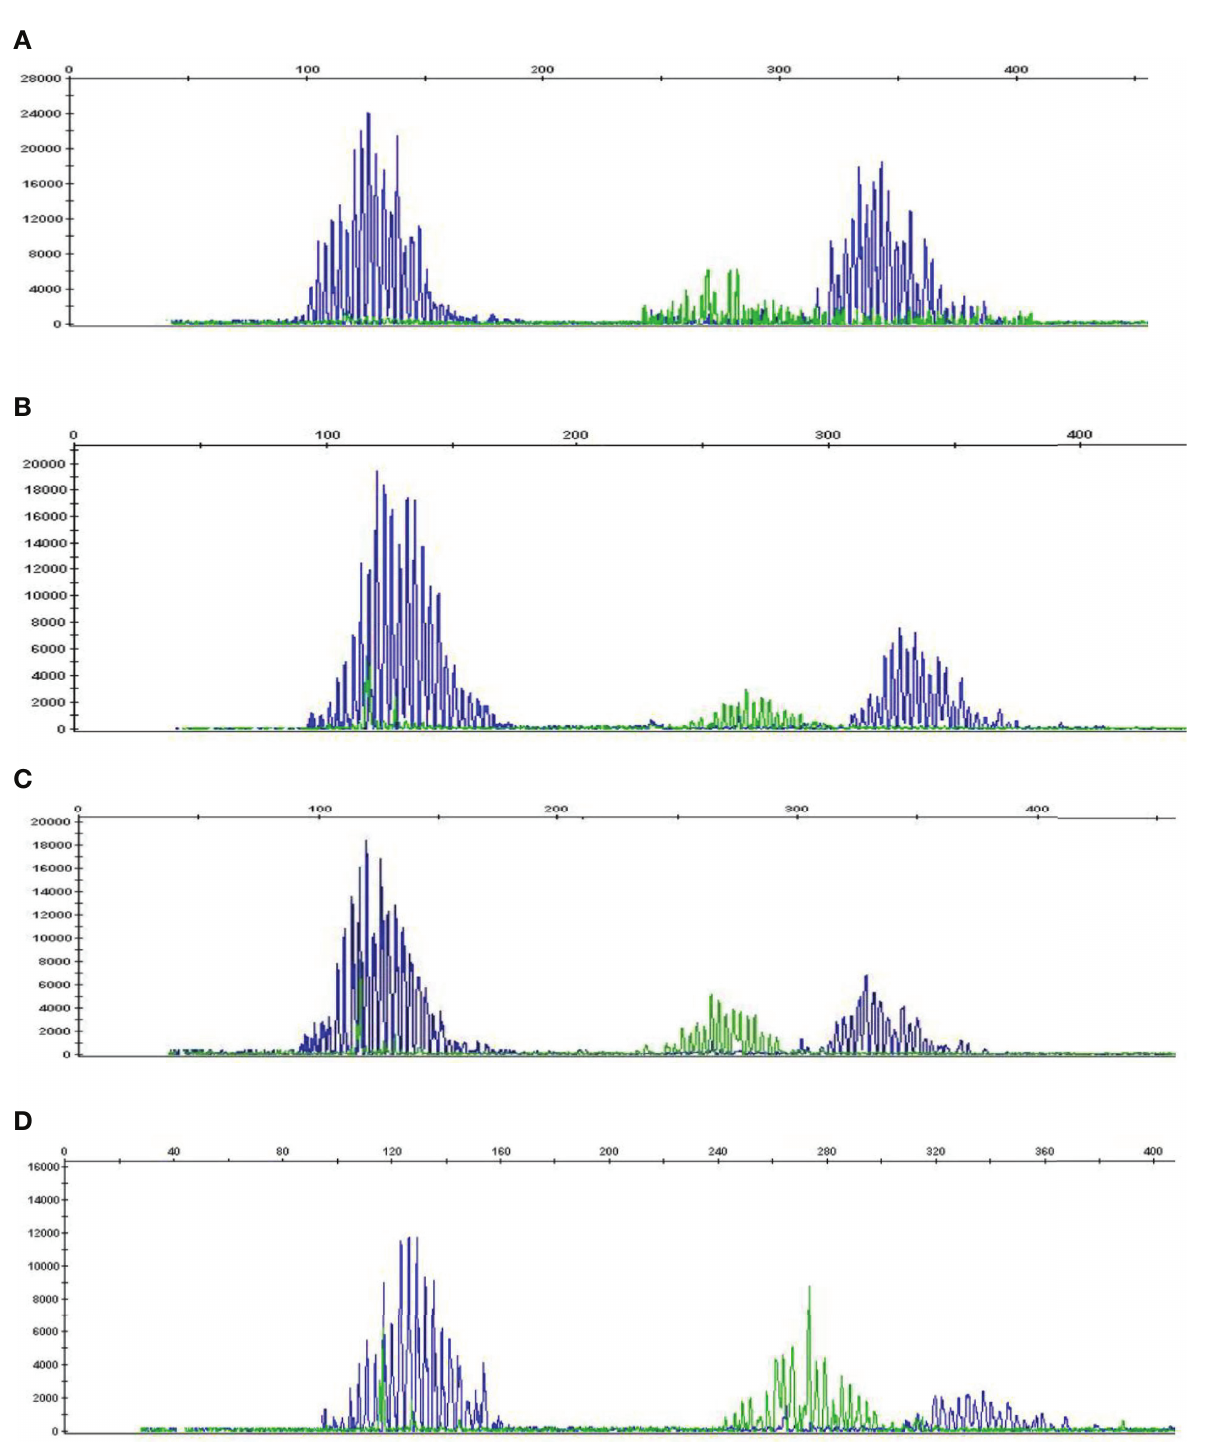
FIGURE 3 | B-cell clonality analysis (IgH gene rearrangements) in PB and BM of HL and NHL patients. Representative graphs showing a Gaussian distribution of multiple peaks in (A) peripheral blood and (B) bone marrow in NHL patient and (C) peripheral blood and (D) bone marrow in HL